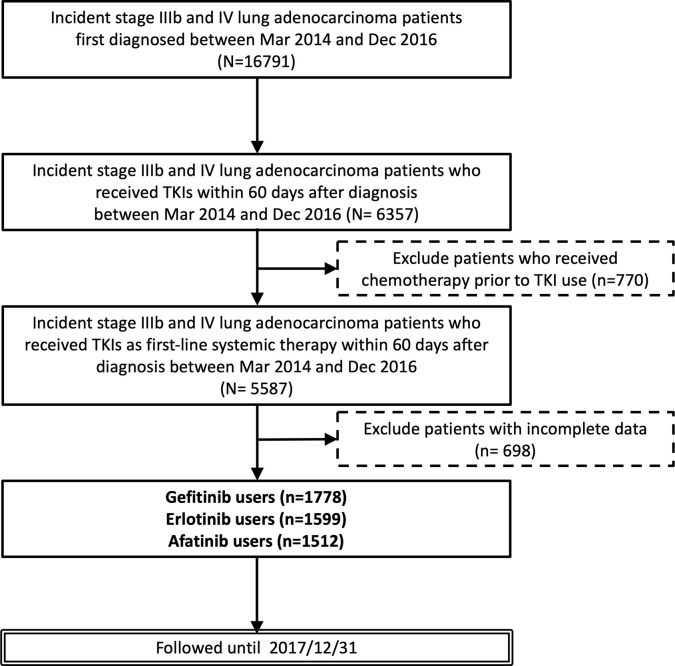
Flow chart of patient recruitment.